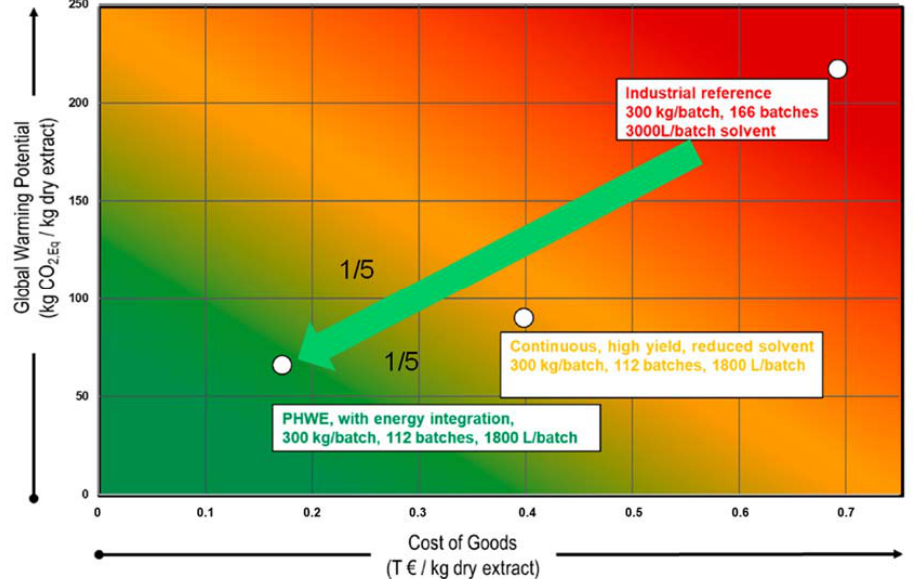
Figure 5. The influence of the extraction processes on the global warming potential and production costs [26] .